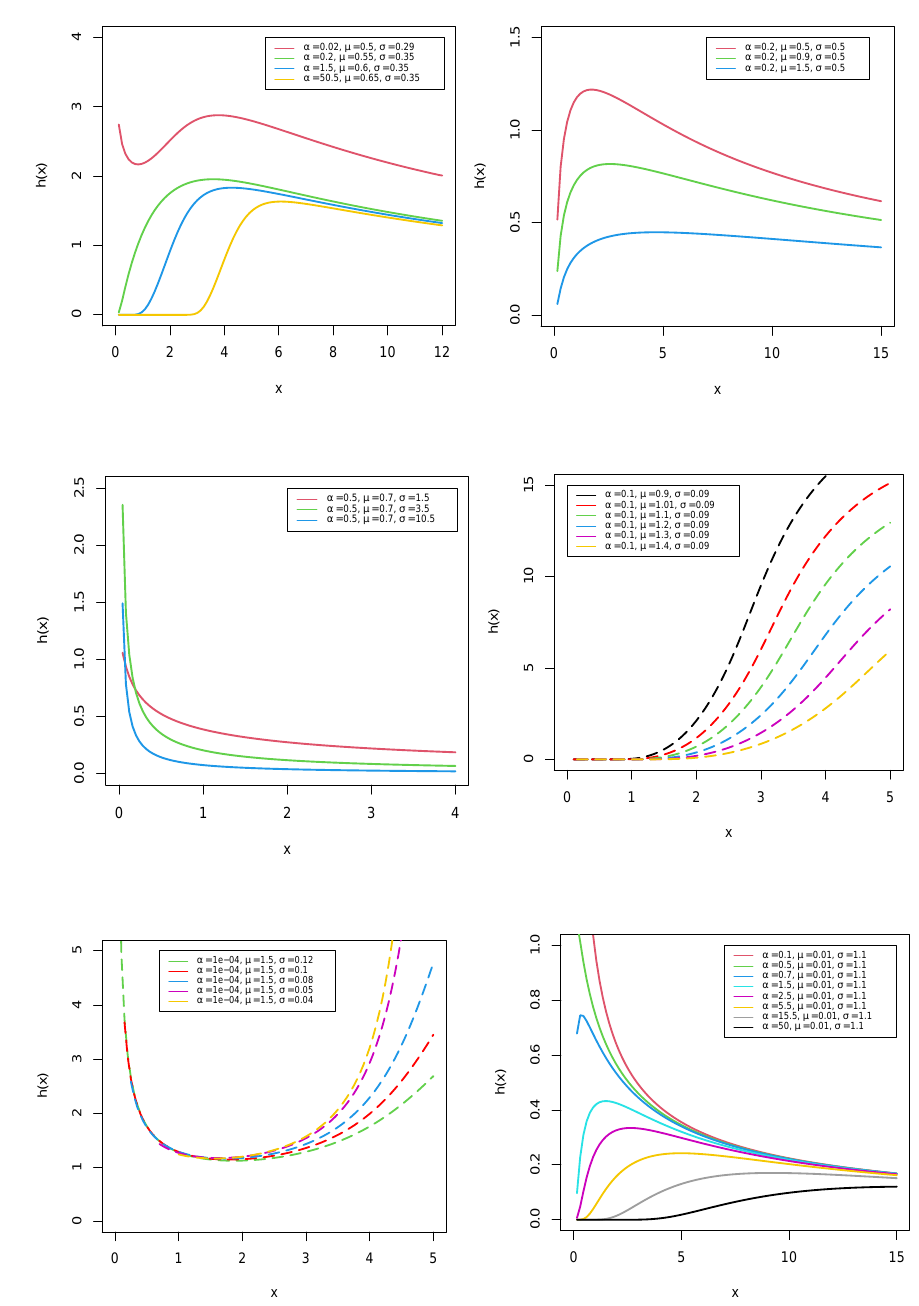
Figure 3. Plots of the hazard rate function of the GDUSLN distribution.